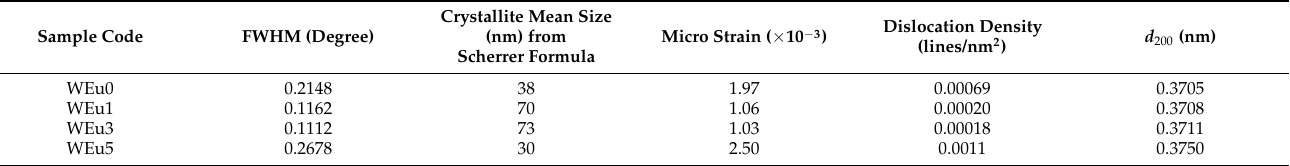
Table 1. Structural parameters of the un-doped and Eu 3+ -embedded WO 3 films annealed at 600 ◦ C. Sample